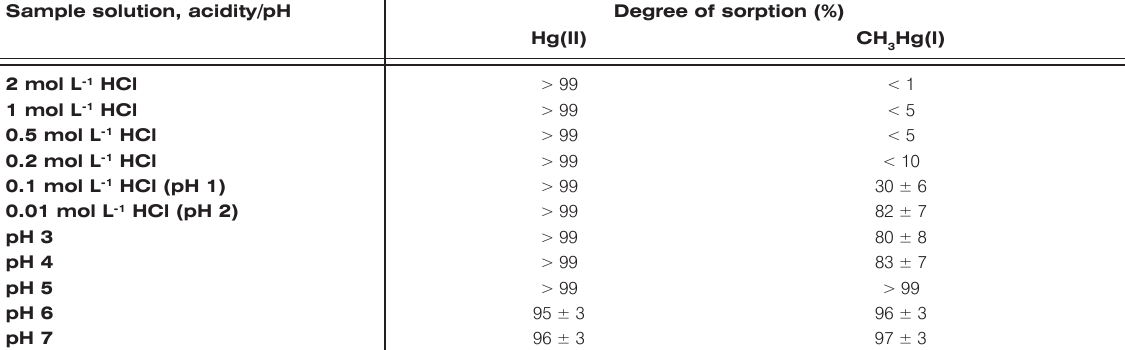
Hg(I) (mean of 3 measurements ± sd.). 3